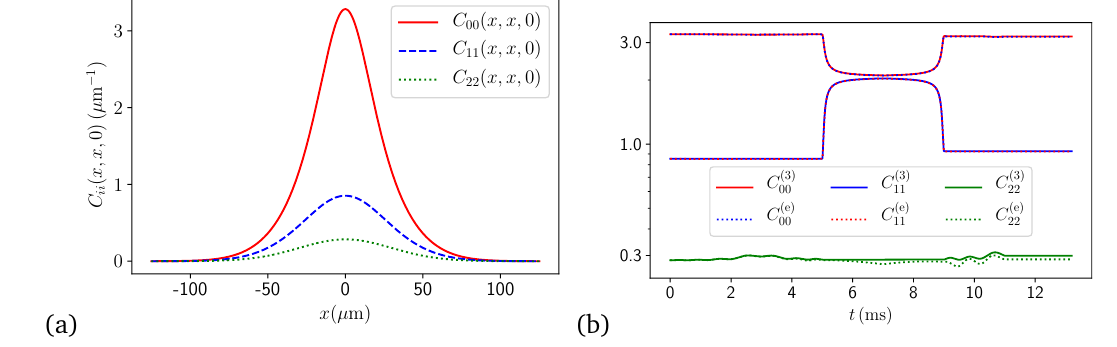
= 2 π · 12.5Hz x ˆ ψ = 〈 ˆ ψ † 〉 for the quantum ii i i = 0. We compare the ijkl 22